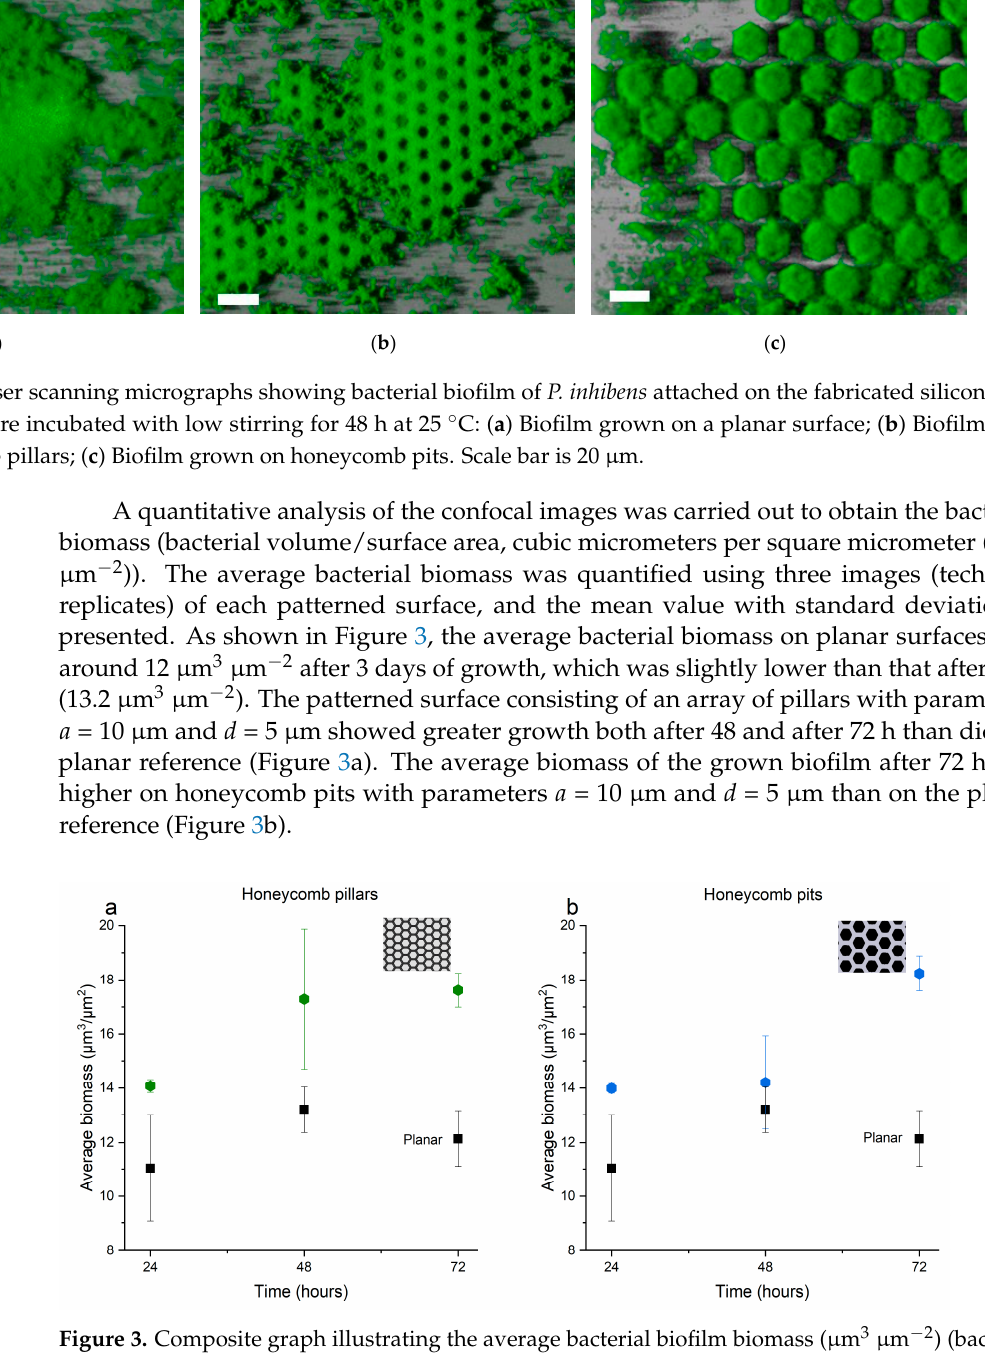
Figure 4. Average bacterial biofilm biomass (µm 3 µm − 2 ) (bacterial volume/surface area) of Phaeobac- ter inhibens biofilm on the honeycomb pillar surfaces, as a function of trench width 𝑑 . Data are de- picted as mean + SD (n = 3). The straight line serves as a baseline, as it indicates the average biomass on the planar surface, with the standard deviation for the planar surface shown with dashed lines.